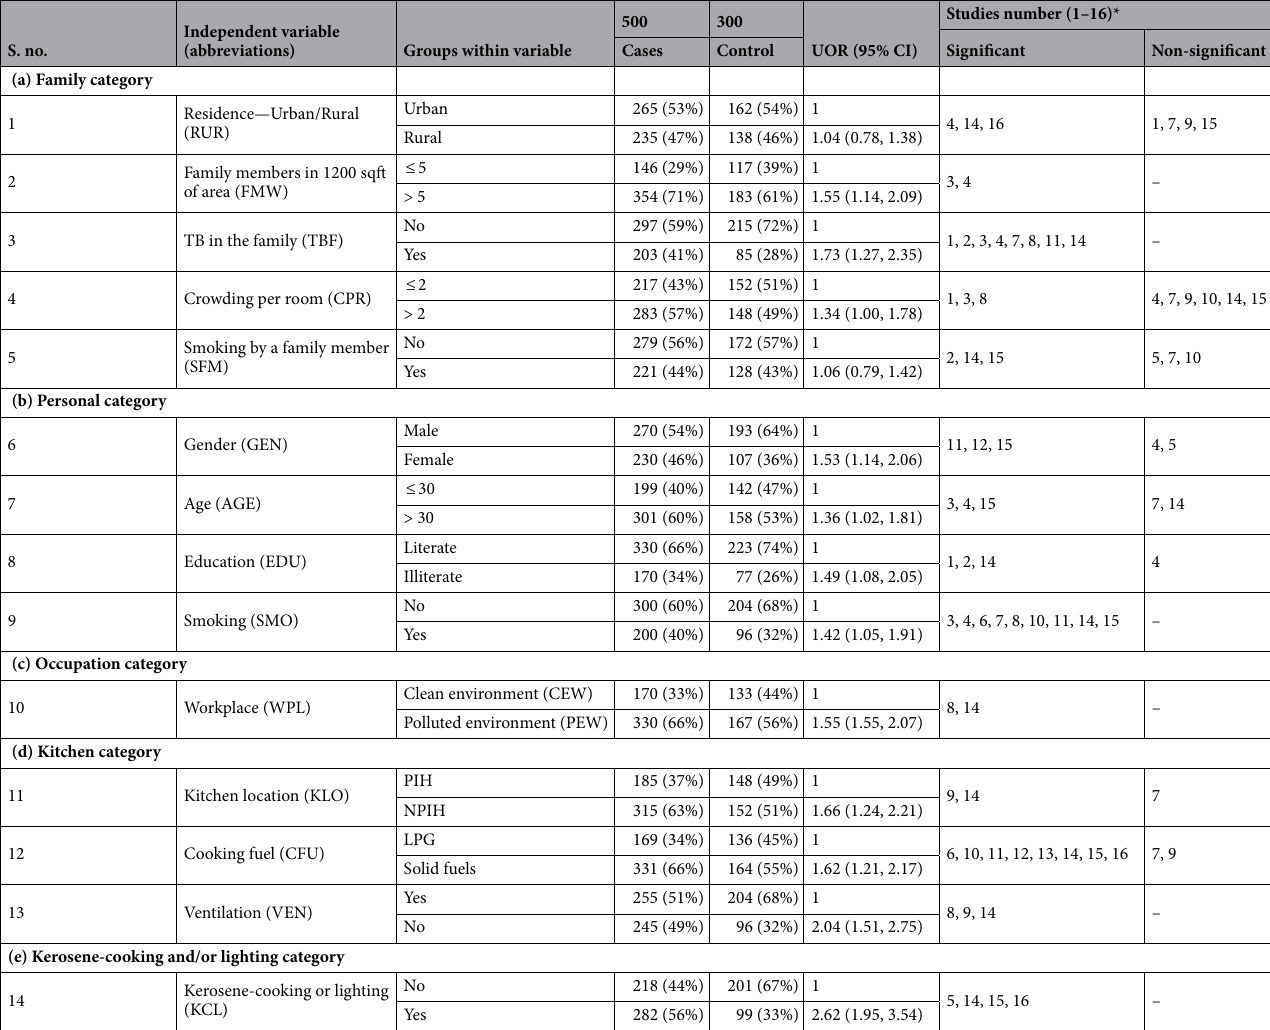
Table 1. UOR for Independent Variables and significance levels. *1 3 ; 2 59 ; 3 4 ; 4 9 ; 5 60 ; 6 13 ; 7 34 ; 8 39 ; 9 37 ; 10 61 ; 11 12 ; 12 20 ; 13 14 ; 14 23 ; 15 10 ; 16 58